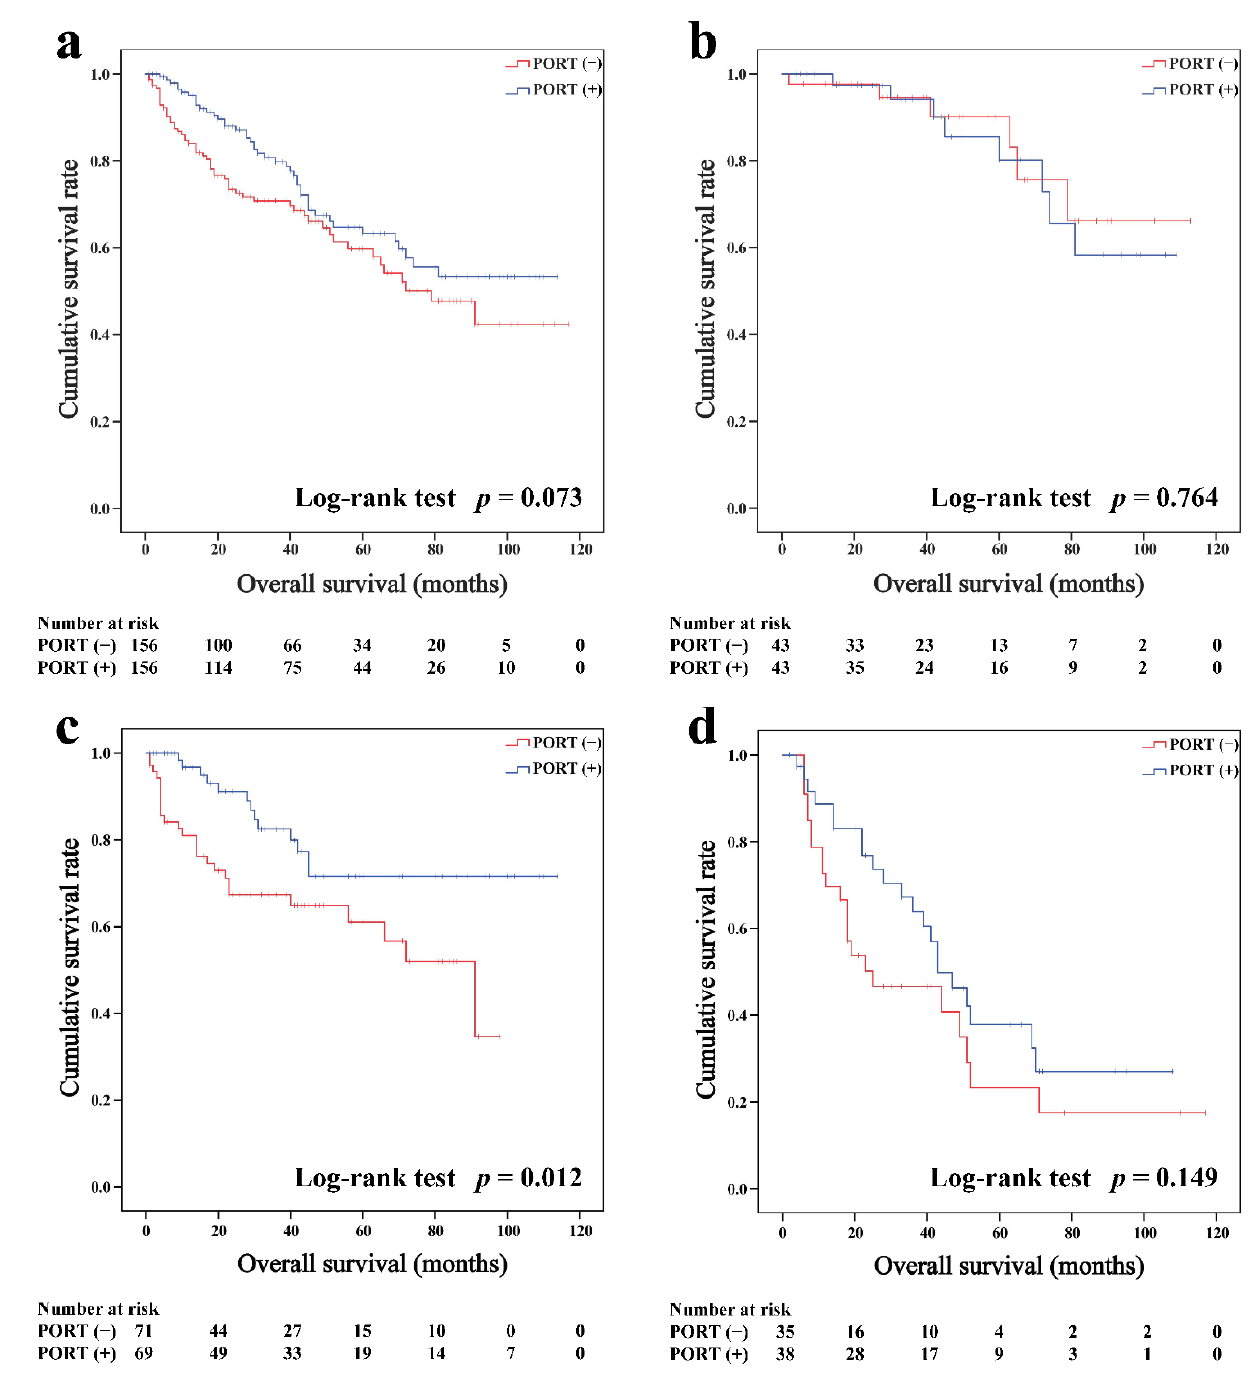
Figure 4. Overall survival in all ( a ), Masaoka-Koga stage I–IIA ( b ), IIB ( c ), and III–IV ( d ) thymic carcinoma patients.